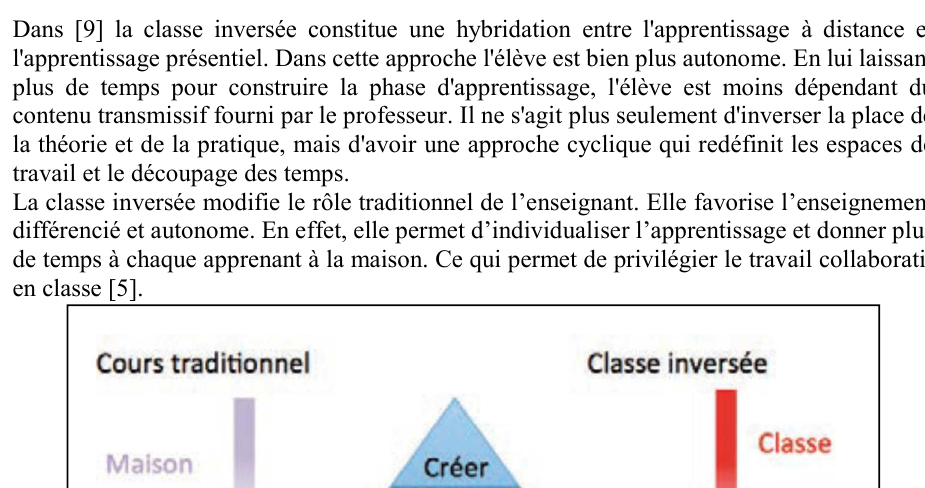
Fig. 10. Padlet outil de travail à distance et de partage des ressources numériques.